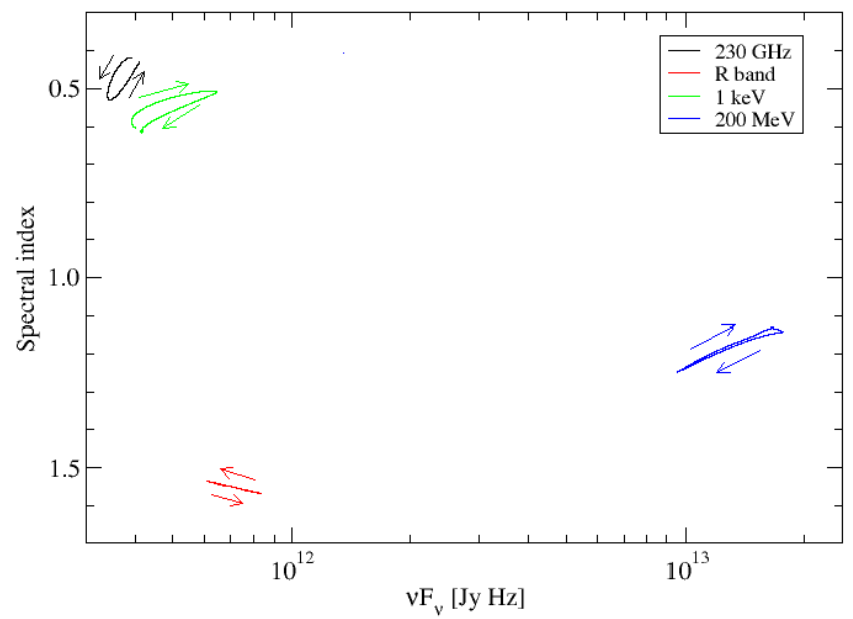
Figure 4. Model hardness-intensity diagrams at the selected frequencies/energies. The spectral index a is defined by F ν ∝ ν − a , so that a smaller value indicates a harder spectrum. The VHE band has been omitted here due to its unobservably low flux level and very steep local spectral index. Arrow indicate the evolution in